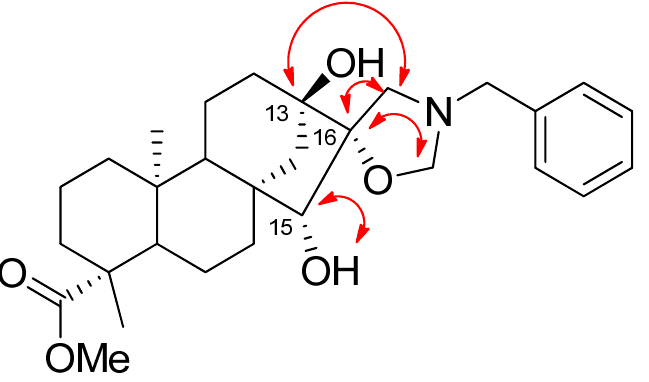
Figure 2. Determination of the structure of derivative 18 by HMBC.